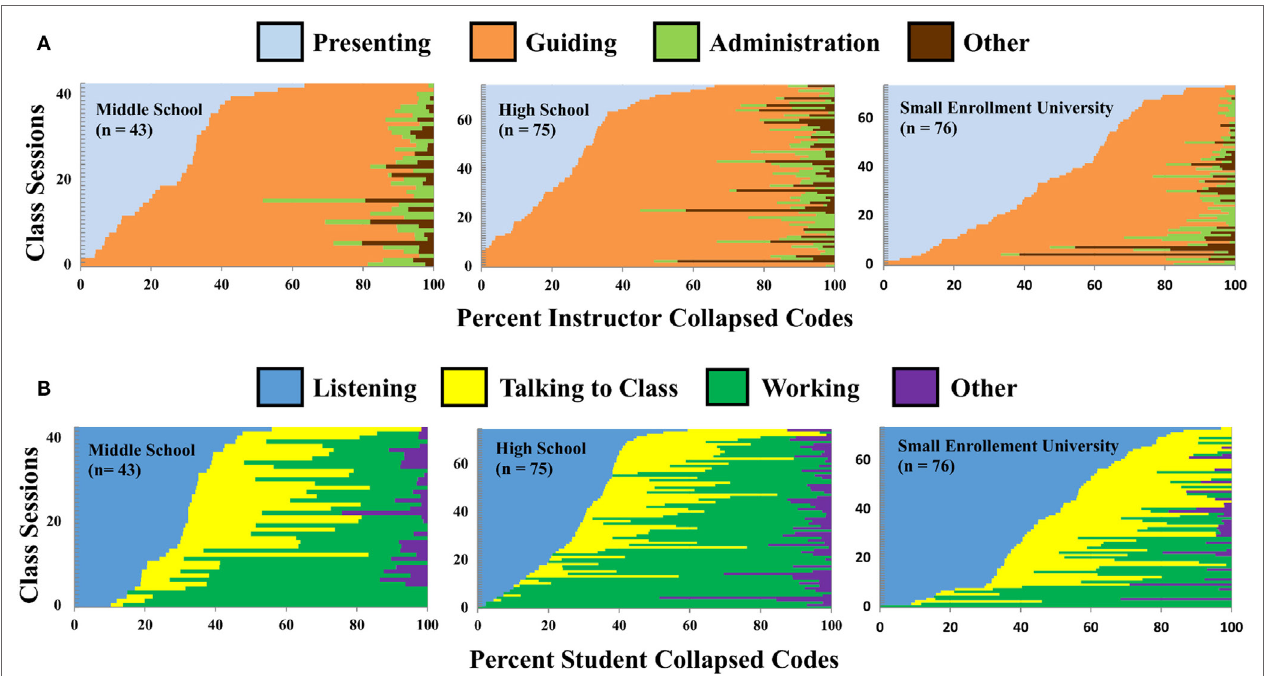
FigUre 9 | A comparison of middle and high school classrooms with small enrollment university classes. (a) Percentage of instructor collapsed Classroom Observation Protocol for Undergraduate STEM (COPUS) codes for middle school, high school, and university classes with fewer than 30 students ordered by percent Instructor Presenting. (b) Percentage student collapsed COPUS codes for middle school, high school, and university classes with fewer than 30 students ordered by percent Student Receiving. Each horizontal bar represents a different class